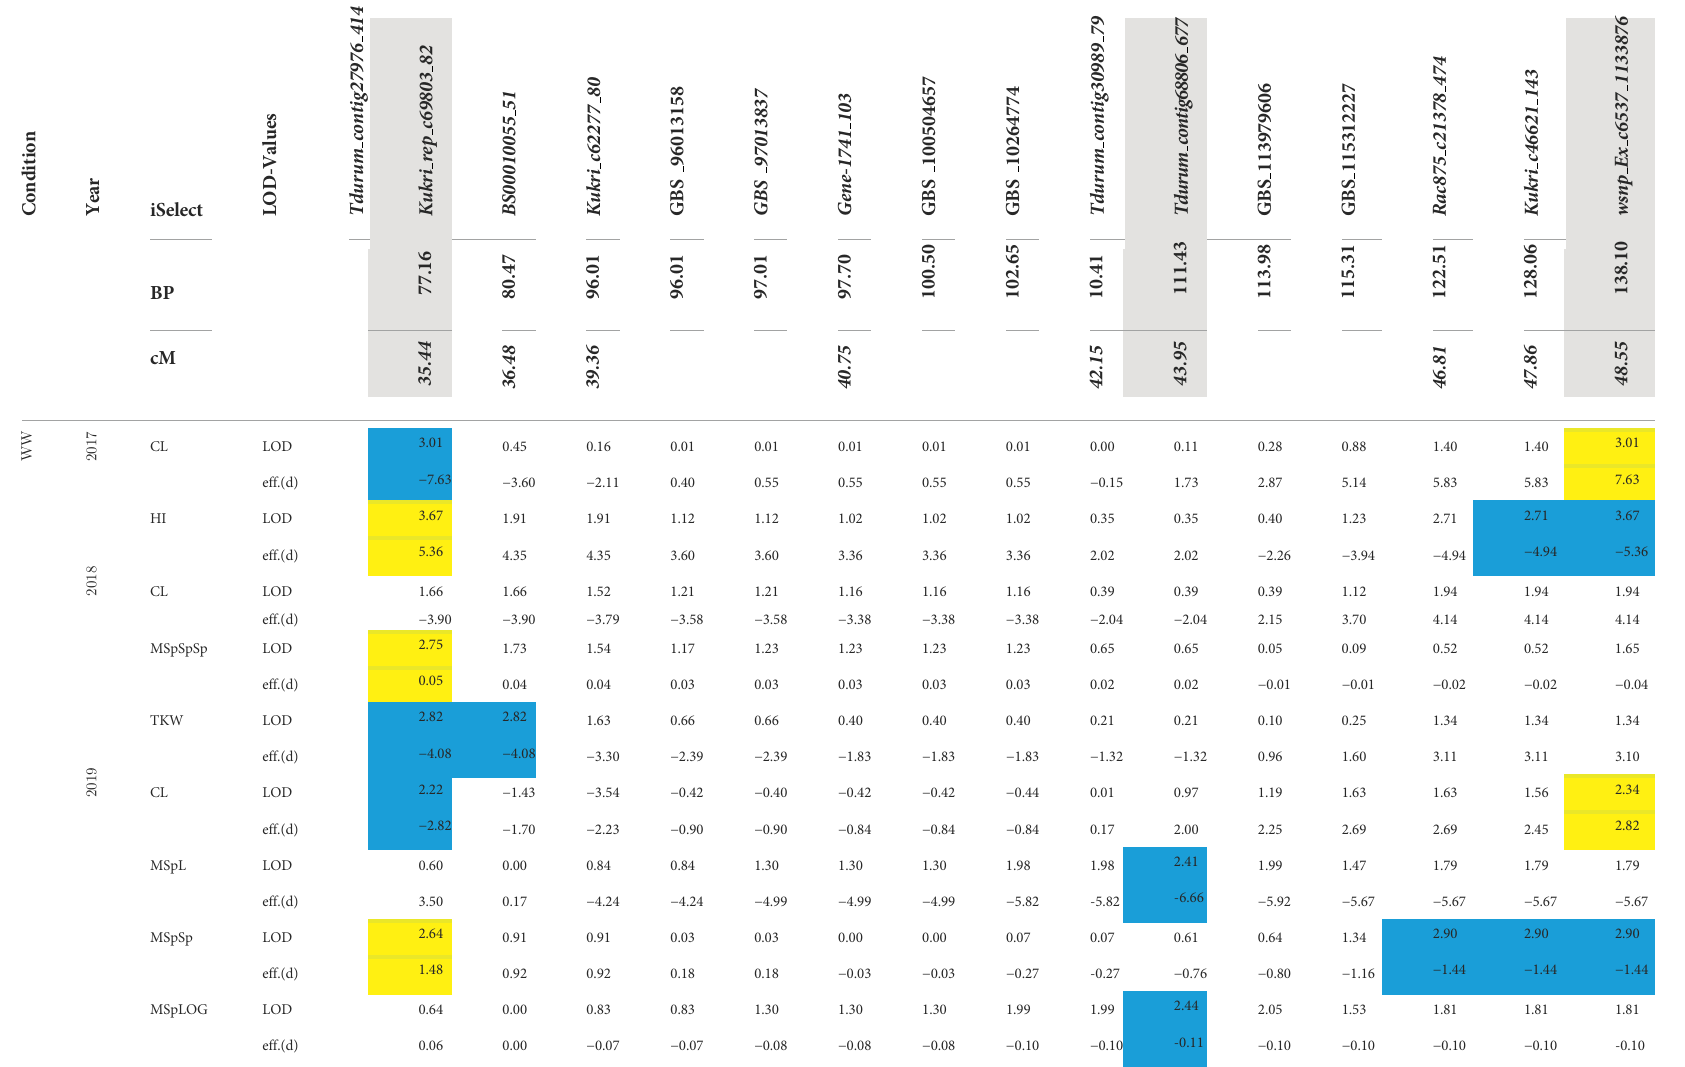
TABLE 4 QTL LOD-values along the target